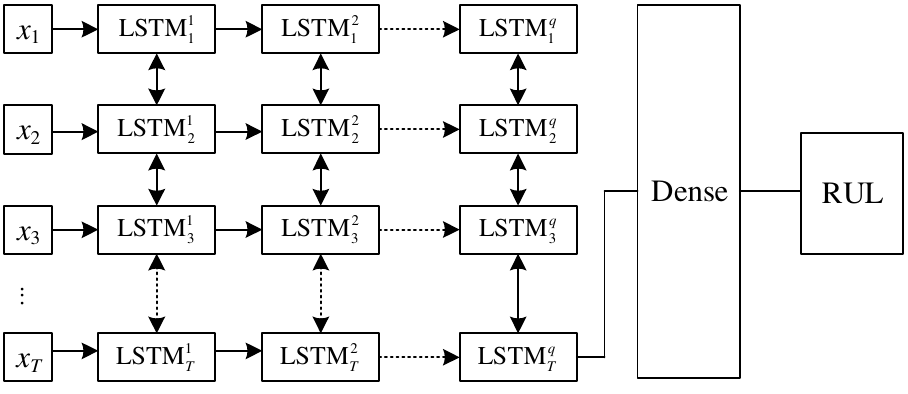
Figure 7. Schematic diagram of multilayer Bi–LSTM structure.